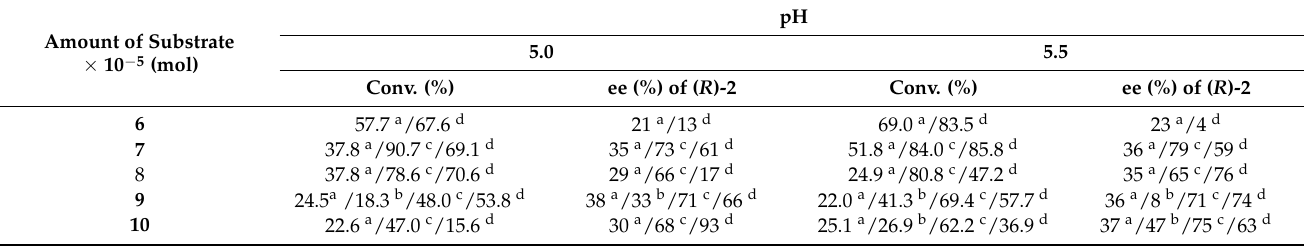
Table 8. Microbial Bioreduction of 1 to ( R )-2-Hydroxy-1,2-Diphenylethanone ( 2 ) in Phosphate Buffer at Different pH Values and Various Concentrations of 1